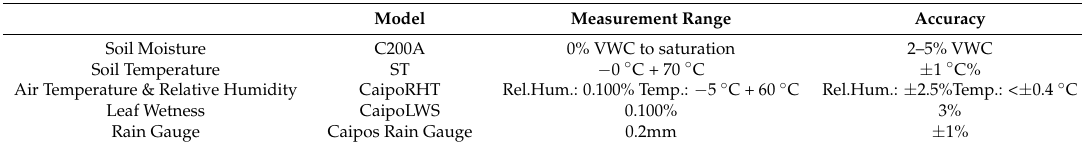
Table 1. Caipos Sensors.